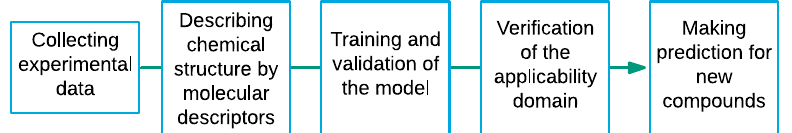
Figure 1. Basic steps that form the process of the quantitative structure-activity/property relationship (QSAR/QSPR) model development.